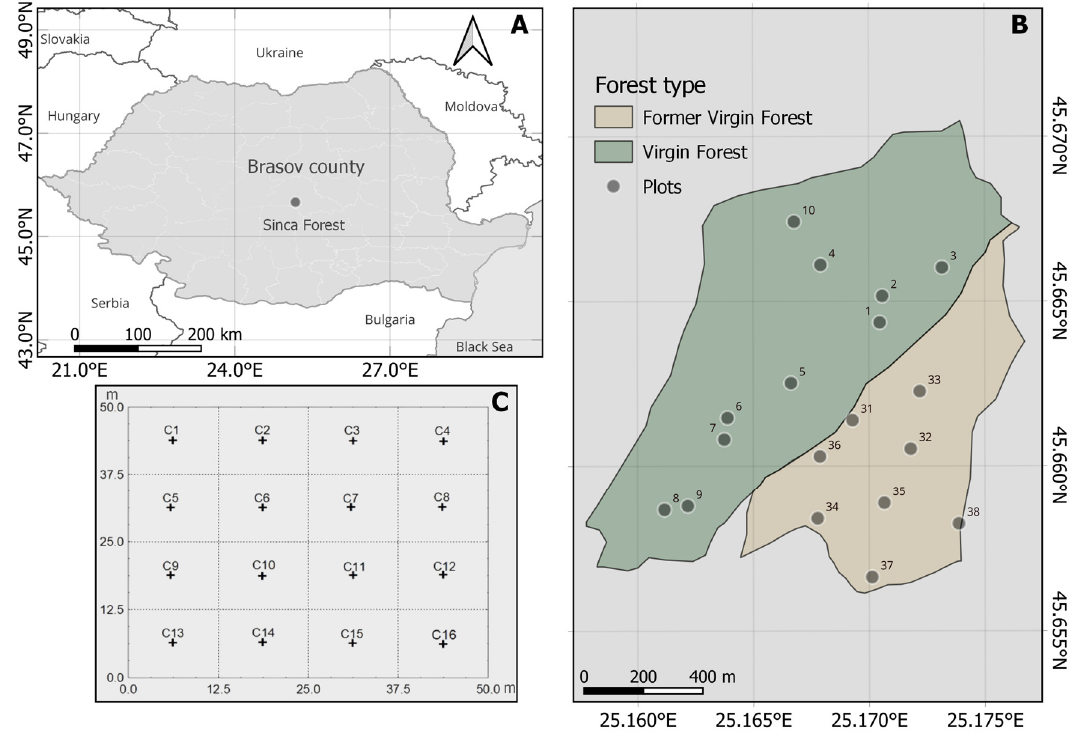
Figure 1. Study area maps: ( A )—Location of Sinca Forest, ( B )—Distribution of plots by each forest type (VF and FVF), ( C )—Experimental design for soil properties and light availability inside of each plot (50 m × 50 m) where C1–C16 represent the center of each subplot.